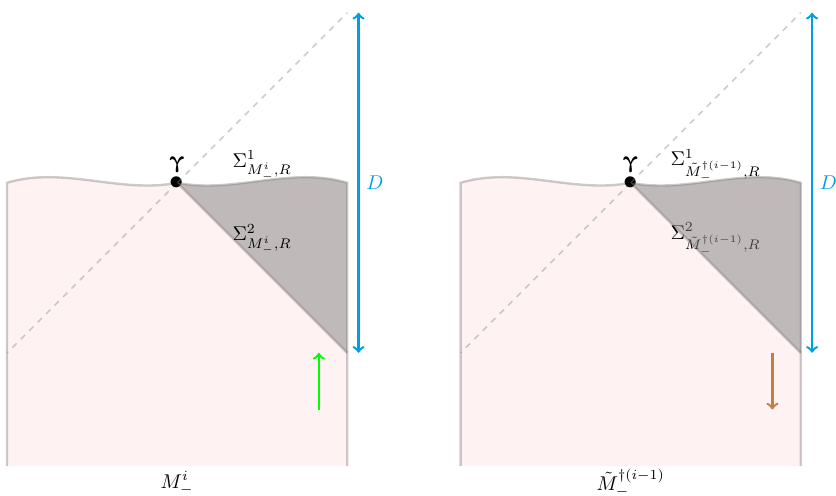
Figure 4 . In every saddle, the sheets M i